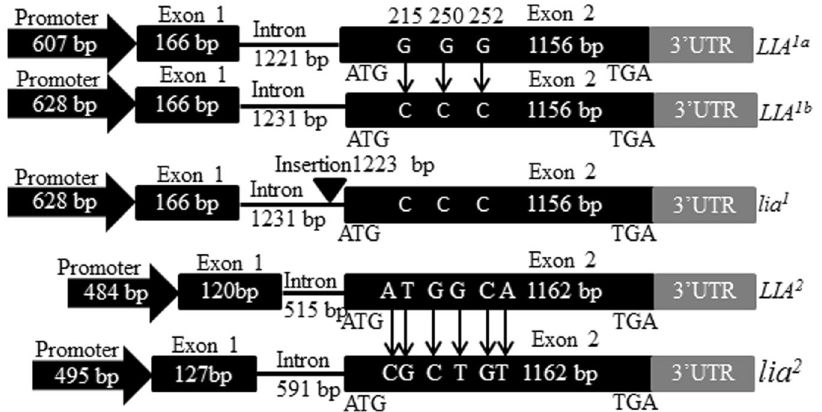
Figure 2. Schematic representation of the structure of the SalFAD2 . LIA1 alleles LIA 1a , LIA 1b , lia 1 and the SalFAD2 . LIA2 alleles LIA 2 and lia 2 . Black rectangle: Exon; Straight line: Intron; Solid black arrow: Promoter; Grey rectangle: 768 bp 3 ′ UTR; Vertical long arrow: Point mutation; Inverted triangle: